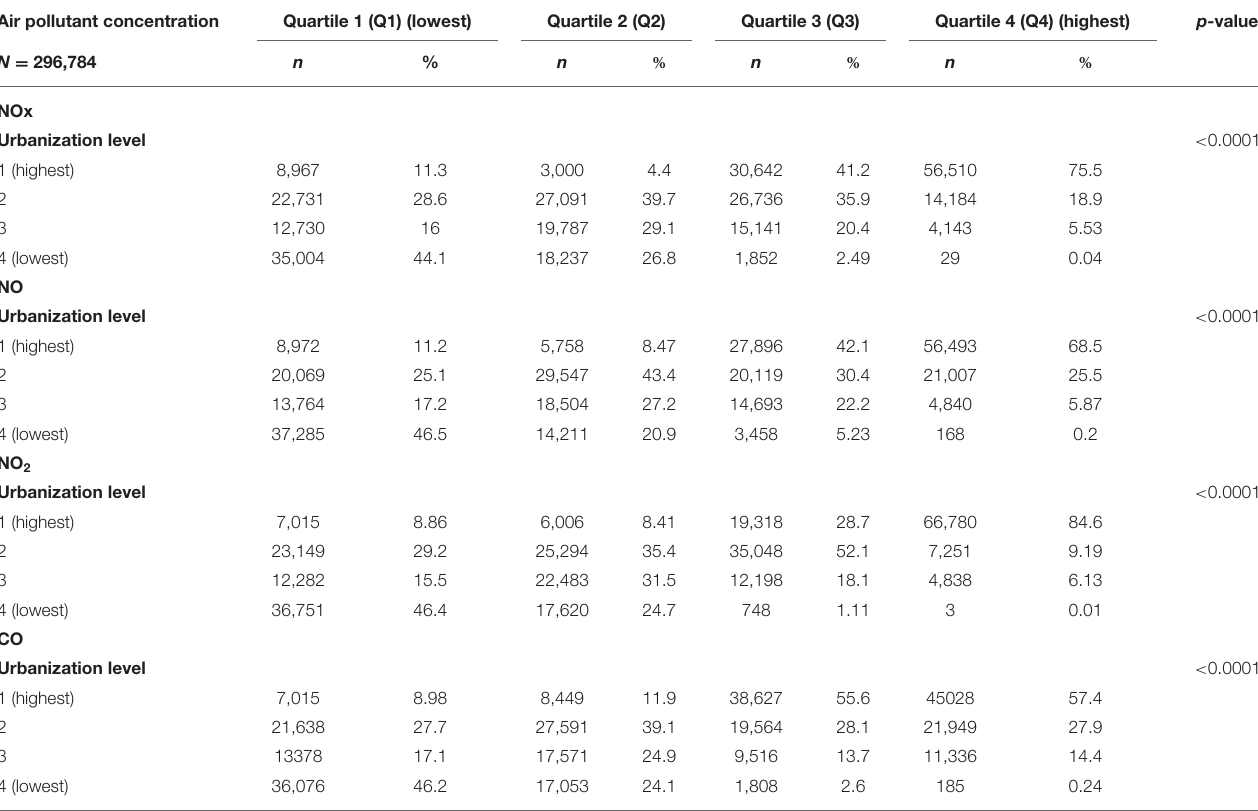
TABLE 2 | Baseline urbanization level among quartiles of daily average concentration of air pollutants in Taiwan. Air pollutant